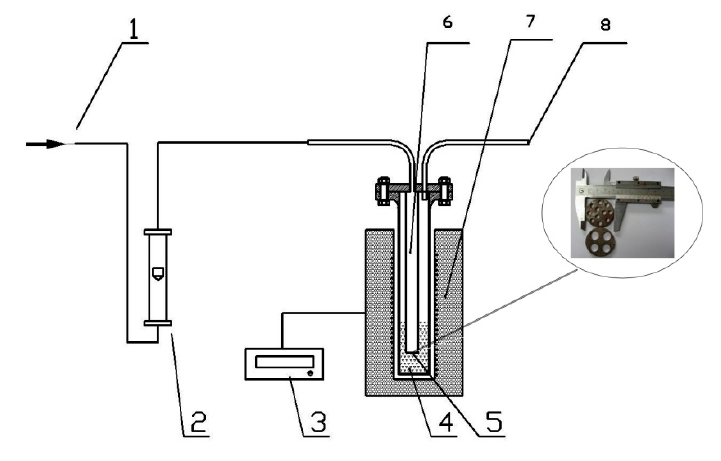
Figure 1. Schematic of the molten salt reactor setup: 1—gas inlet, 2—flowmeter, 3—thermal